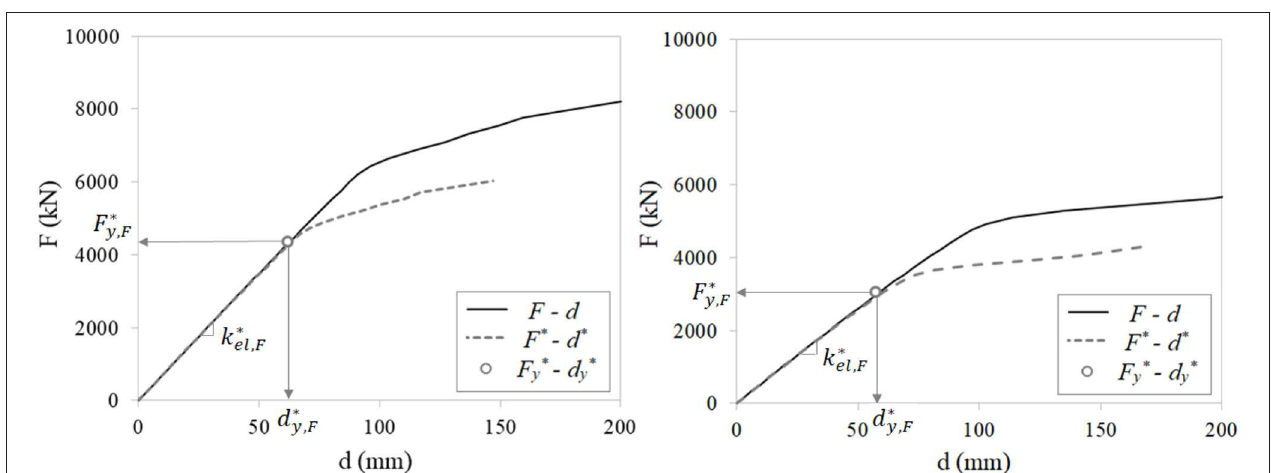
modal component of the ith story, respectively). As an example, Figure 4 shows the capacity curves, both physical and reduced (equivalent SDOF), for block A along the two horizontal